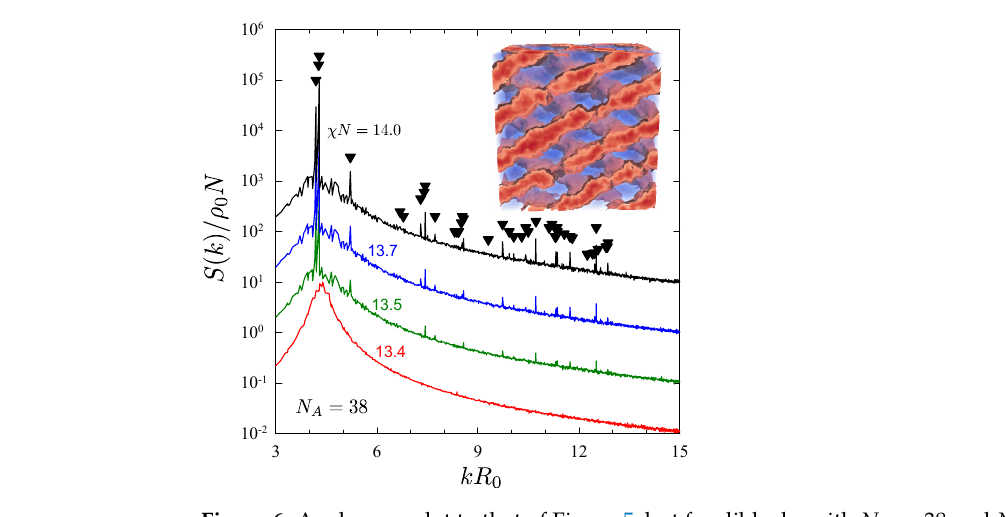
Figure 6. Analogous plot to that of Figure 5, but for diblocks with N A = 38 and N B = 52. The mor- phology (see inset) and peak positions (triangles) confirm that the ordered state is Fddd. Reproduced from Ref. [42].